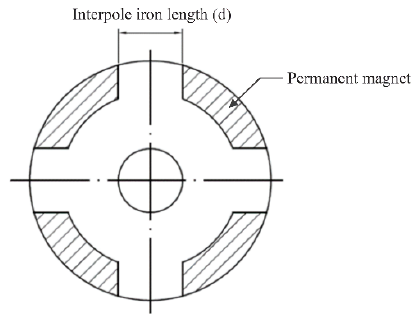
Figure 3. Illustration of the inset magnet rotor.